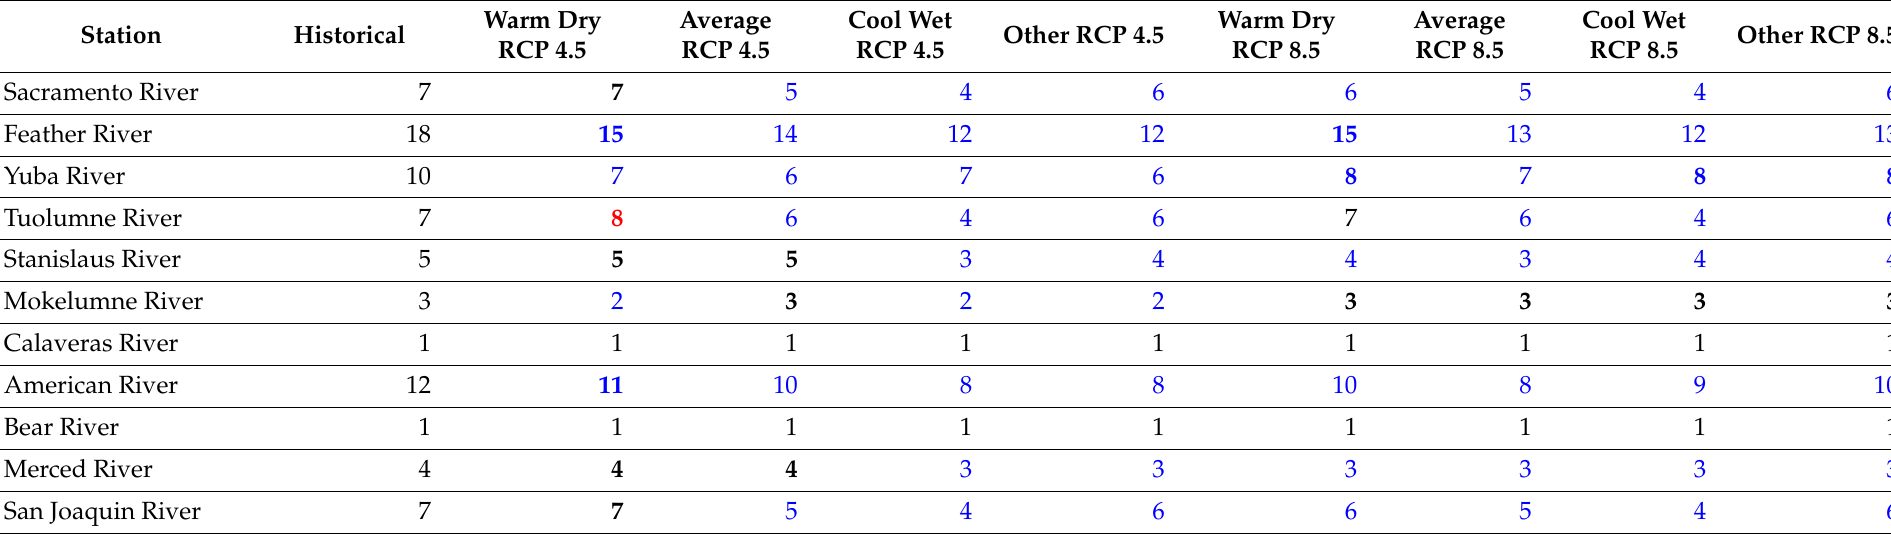
Table 5. Highest drought intensity by projection model for each streamflow station (MAF/year). Each of the values represent the highest drought intensity out of all projected droughts under each climate scenario or historical records. Red highlighting indicates droughts with a higher intensity than historical. Blue highlighting indicates droughts with a lower intensity than historical. Bold values are the highest projected intensity for each station. (Note: 1 MAF = 1233 million cubic